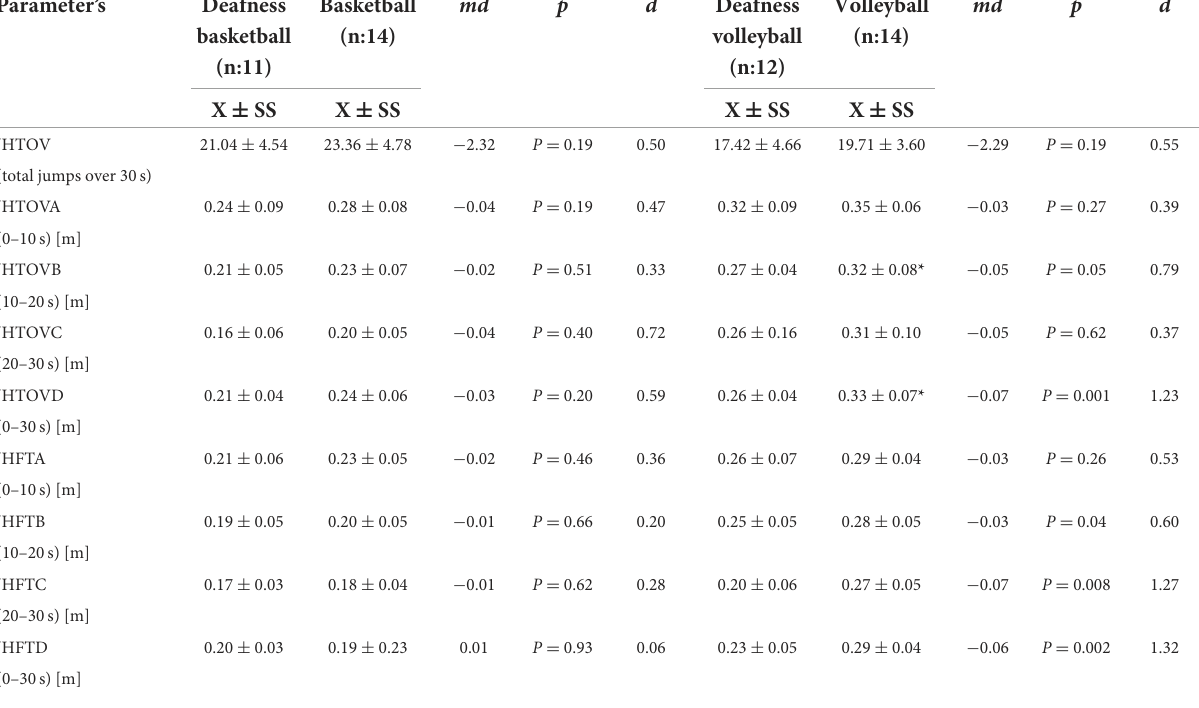
TABLE 1 Comparison of jump height from take off velocity and jump height from flight time of deaf and non-deaf basketball/volleyball players.